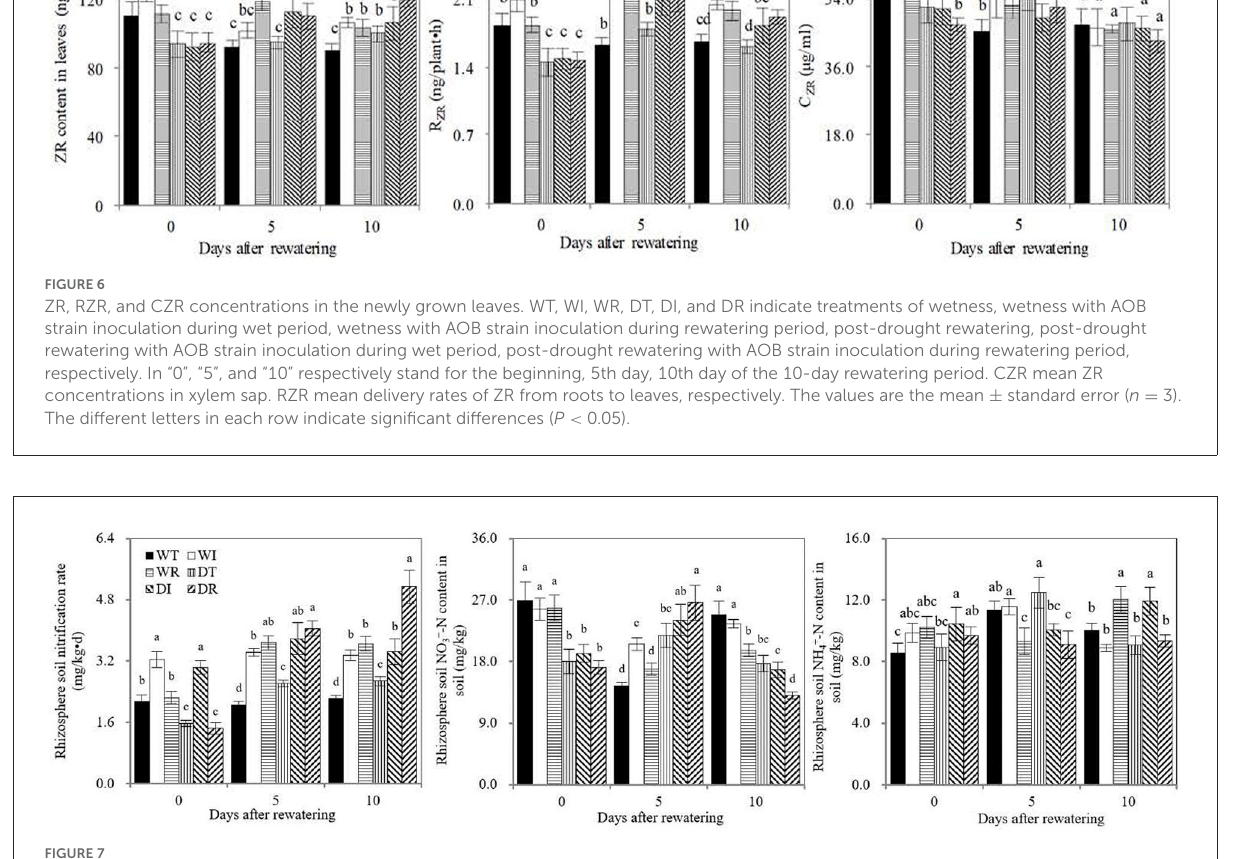
FIGURE7 Soil nitrification rate, soil ammonium and nitrate nitrogen contents in the study. WT, WI, WR, DT, DI, and DR indicate treatments of wetness, wetness with AOB strain inoculation during wet period, wetness with AOB strain inoculation during rewatering period, post-drought rewatering, post-drought rewatering with AOB strain inoculation during wet period, post-drought rewatering with AOB strain inoculation during rewatering period, respectively. In “0”, “5”, and “10” respectively stand for the beginning, 5th day, 10th day of the rewatering period of 10 days. The values are the mean ± standard error ( n = 3). The different letters in each row indicate significant differences ( P <